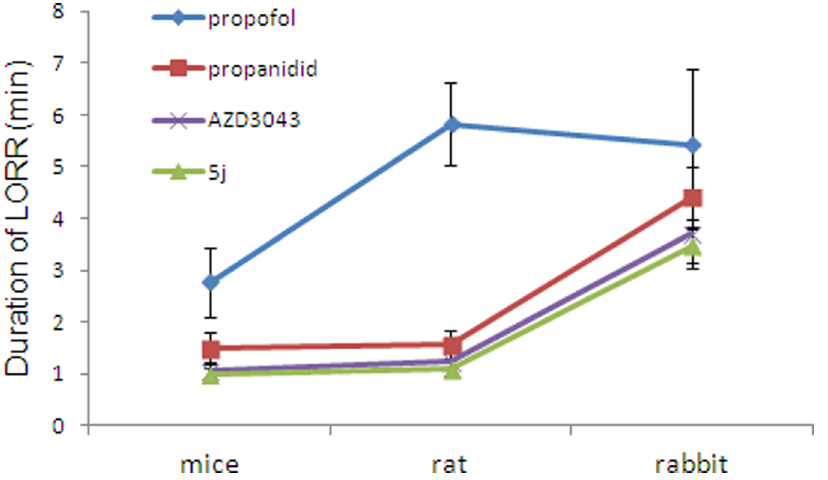
Figure 4. Duration of LORR in mice, rat and rabbit. 2 6 HD 50 administration in mice, rat and rabbit (n=10 in mice, n=8 in rat, n=6 in rabbit for each tested